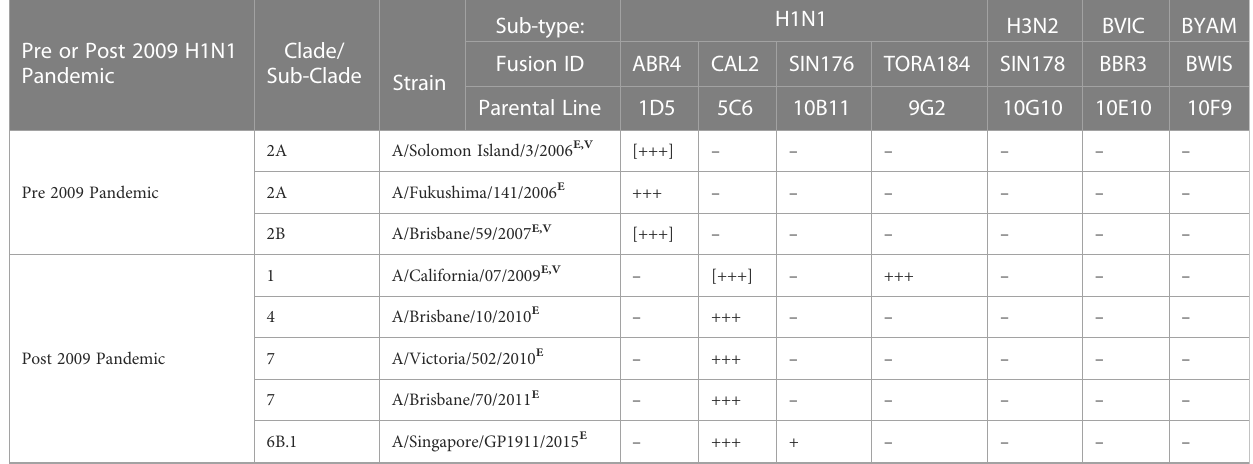
Pre or Post 2009 H1N1 Pandemic